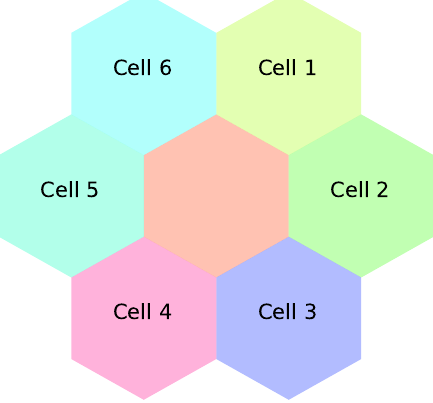
Figure 3. An example for a cell with its six neighboring cells.